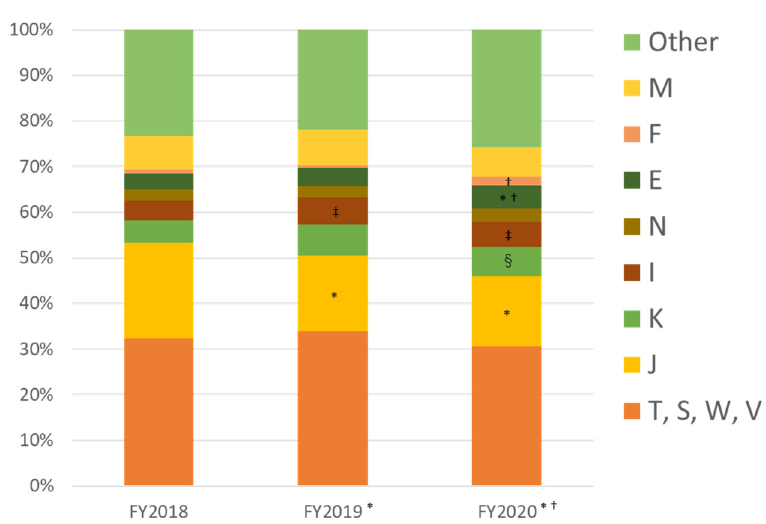
Figure 11. Proportion of outpatients by ICD classification, FY2018-FY2020. * p < 0.001 vs. 2018; † p < 0.001 vs. 2019; ‡ p = 0.005, § p = 0.002 vs. 2018. The proportions of J decreased, but E, I, and K increased compared with FY2018 (*, †, §). The proportion of E increased compared with FY2019 (†). ICD: International Classification of Diseases. (M: diseases of the musculoskeletal system and connective tissue; F: mental and behavioral disorders; E: endocrine, nutritional, and metabolic diseases; N: diseases of the genitourinary system; I: diseases of the circulatory system; K: diseases of the digestive system; J: diseases of the respiratory system; S, T: injury, poisoning, and certain other consequences of external causes; and V, W: external causes of morbidity and